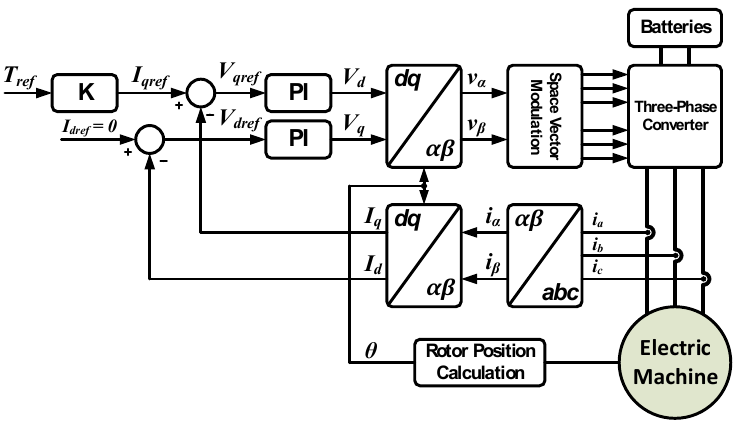
Figure 14. Block diagram of the implemented field-oriented control (FOC). The parameters of the brushless dc (BLDC) electric machine used in the simulation are presented in Table 2. Table 2. BLDC electric machine simulation parameters.